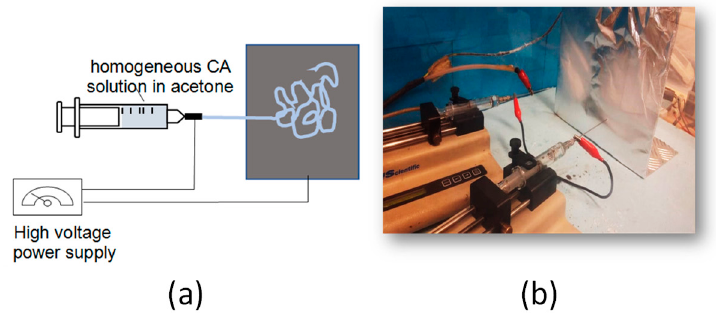
Figure 1. Schematic representation ( a ) and photograph ( b ) of the electrospinning set-up. The latter shows two spinnerets connected in series. Upon applying a high voltage, cellulose acetate (CA) fibers are ejected from the spinnerets and they are deposited onto the metallic collector. Electrospinning conditions: CA solution in acetone: Solution concentration 12.5% w / v ; needle diameter: 16 G; applied